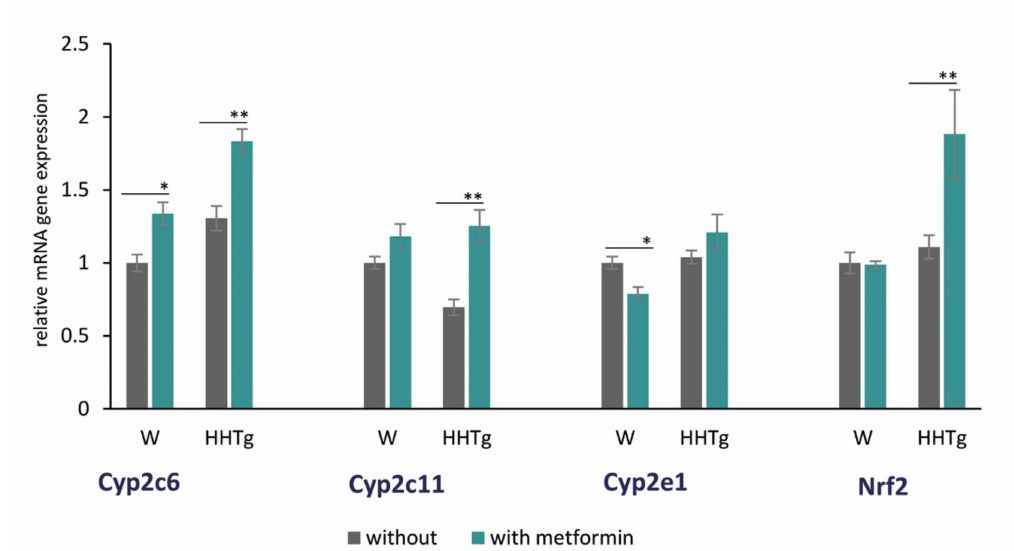
Figure 5. Effects of metformin on relative mRNA expression of some CYP450 family proteins expressed in myocardium and nuclear factor Nrf2 in Wistar control (W) and hereditary hypertriglyceridemic (HHTg) rats. Data are mean ± SEM; n = 8 for each group. Significance was determined using two-way ANOVA and Fisher’s LSD post-hoc test (* denotes p < 0.05; ** denotes p <